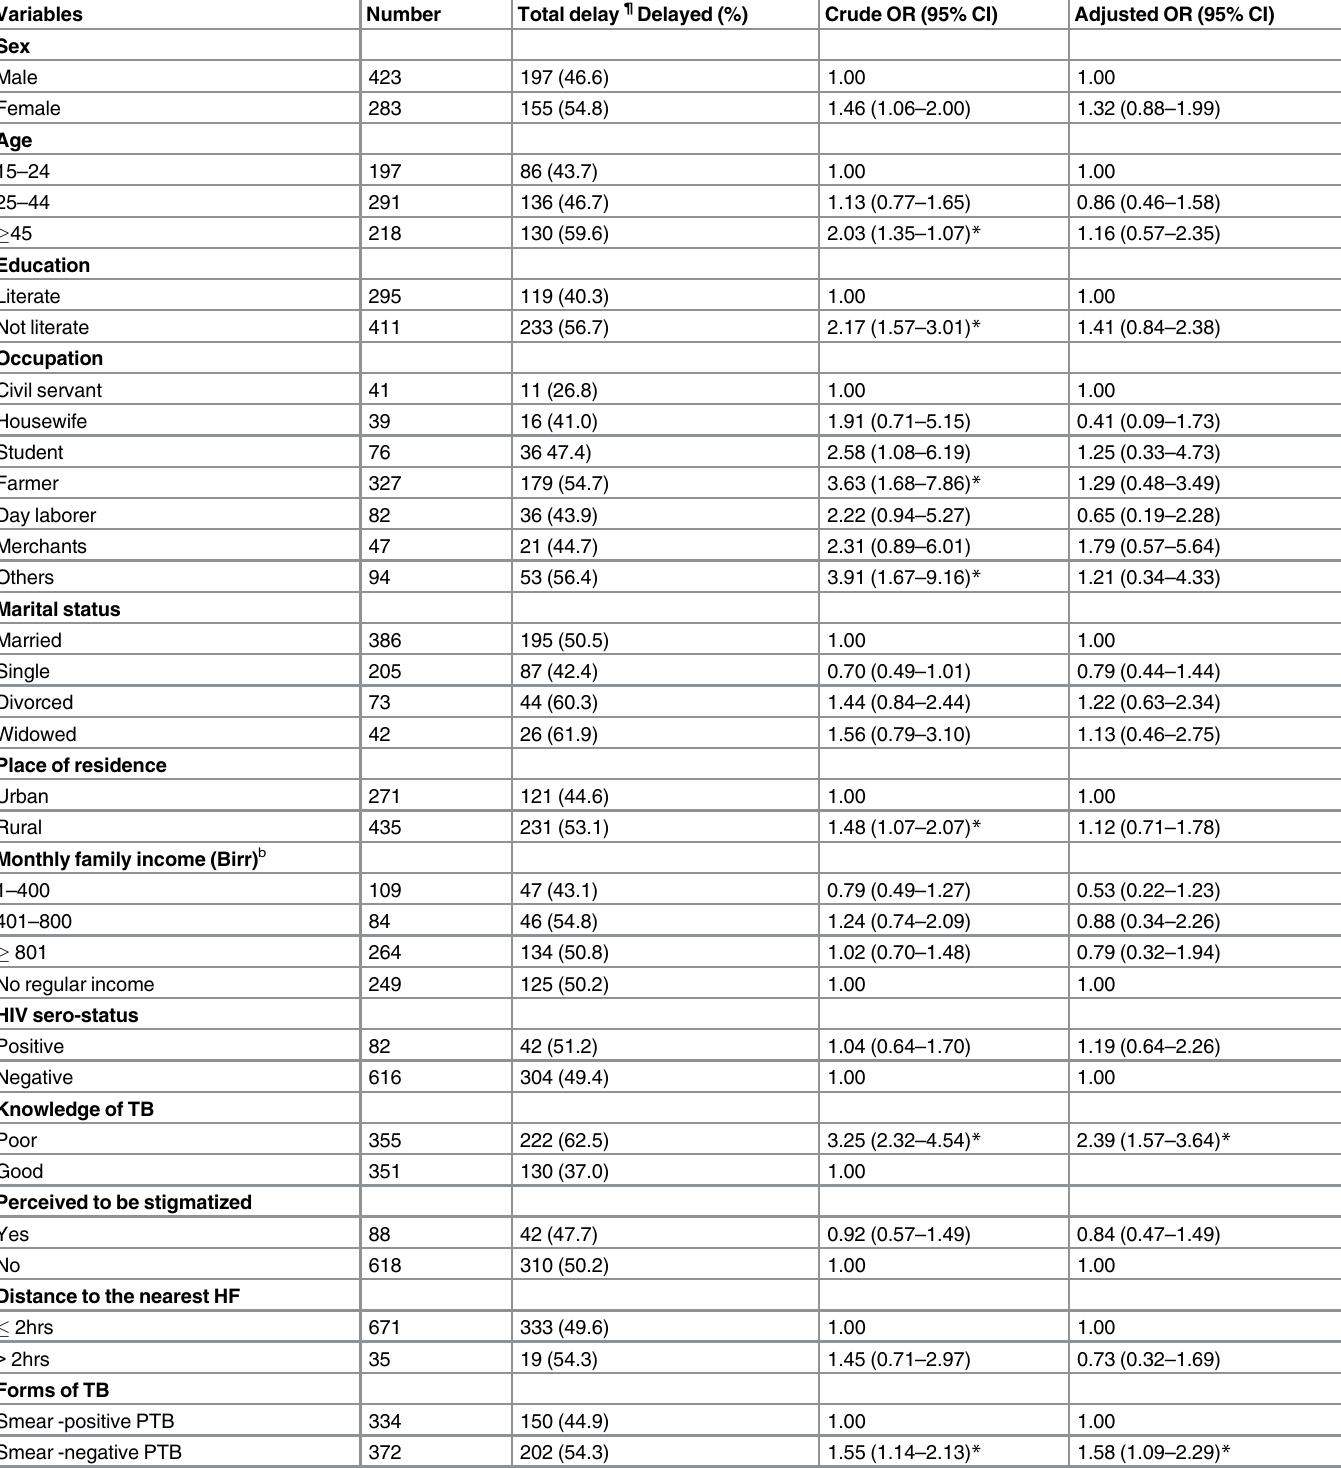
Table 4. Associations of socio-demographic and clinical factors with total delay of new PTB patients, October 2013 to May 2015, West Gojjam Zone,